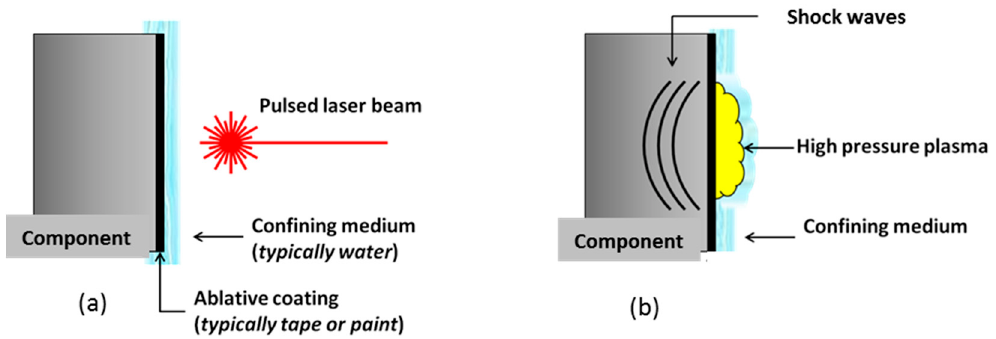
Figure 1. ( a ) A high-intensity, pulsed laser vaporizes an ablative layer on the surface of the component, producing a rapidly expanding plasma. ( b ) The plasma is constrained by a confining medium, which creates a high-amplitude pressure pulse and induces a shock wave in the component.